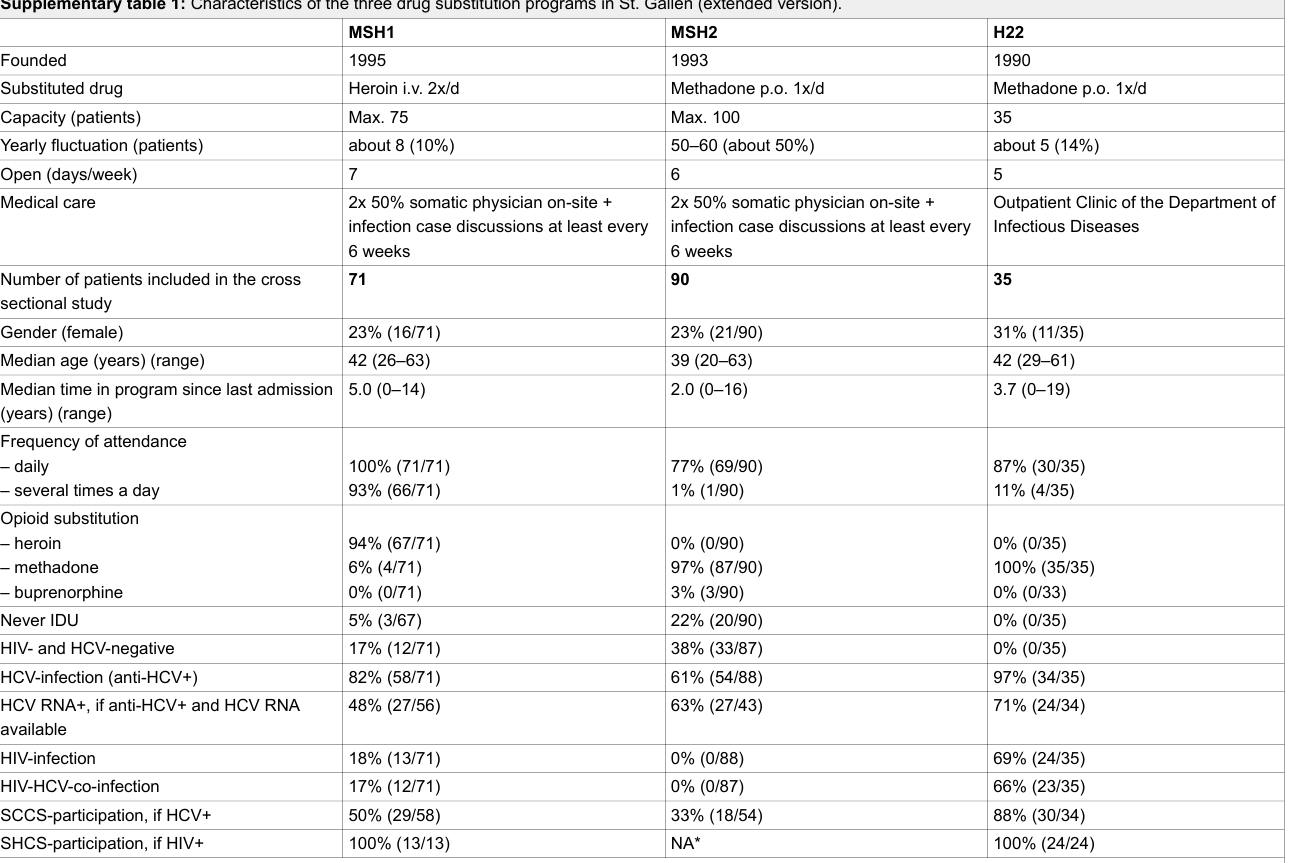
Supplementary table 1: Characteristics of the three drug substitution programs in St. Gallen (extended